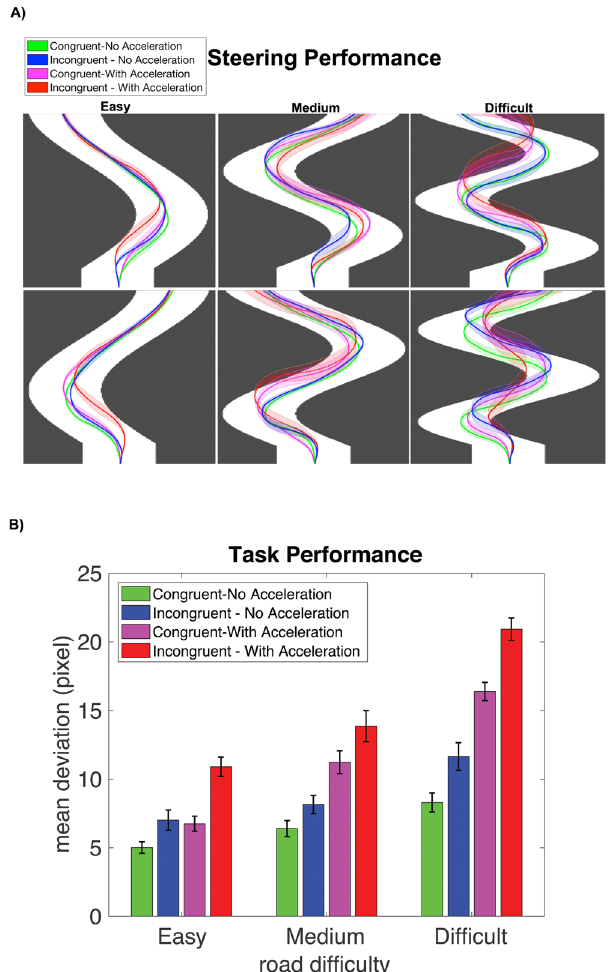
Figure 1. Average steering performance across conditions. ( A ) The shaded lines show mean (standard error) of the steering path across different conditions. The green (pink) lines indicate congruent steering with (w/o) acceleration and blue (red) lines indicate incongruent steering with (w/o) acceleration. ( B ) Mean (standard error) of deviation from the center of the road across different conditions. The green (pink) bars indicate congruent steering with (w/o) acceleration and blue (red) bars indicate incongruent steering with (w/o)